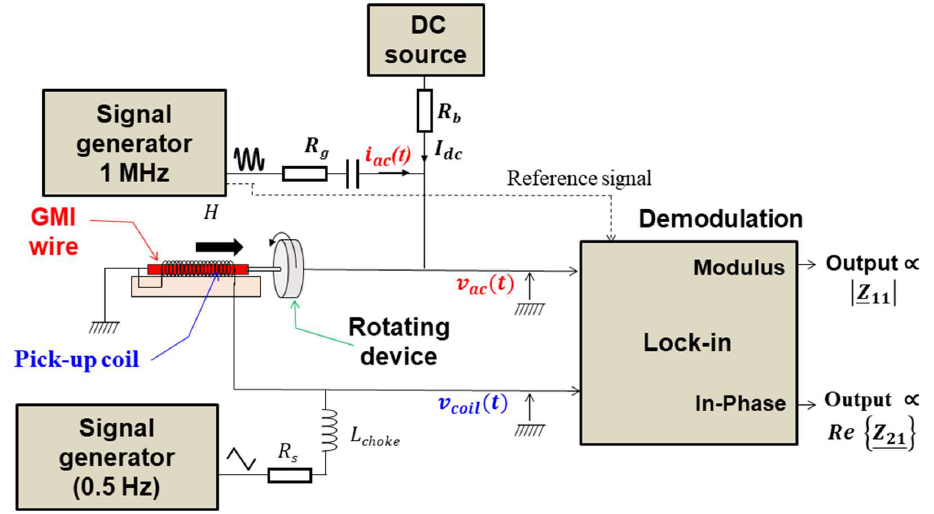
Figure 3. Schematic of the experimental setup for the investigation of the torsion stress effect on GMI in amorphous wires.